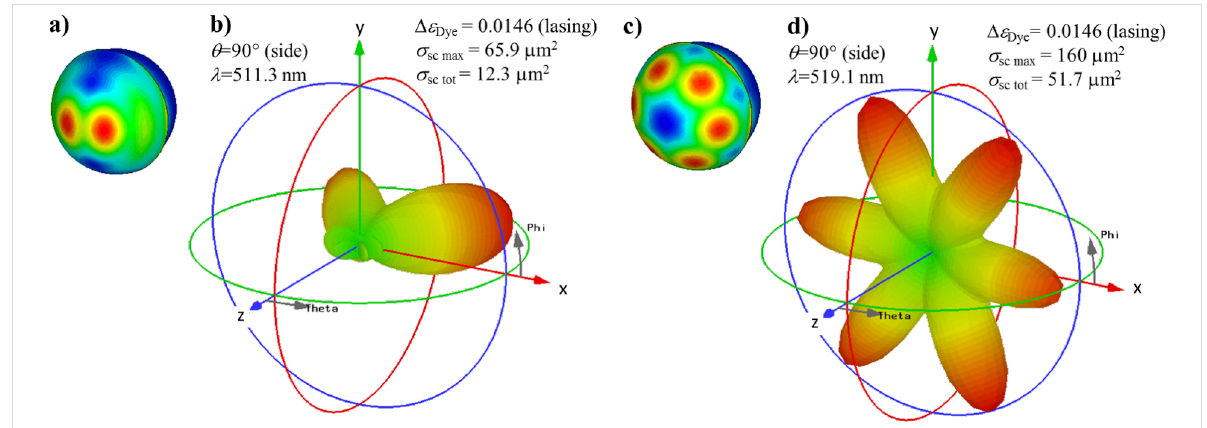
Figure 8: (a,c) Field enhancement | E |/ E 0 for two modes with gain close to the lasing threshold. The z-polarized incoming plane wave propagates in x-direction ( θ = 90°, φ = 0°). The two wavelengths 511.3 nm (a) and 519.1 nm (c) are close to the two peaks in Figure 6d. The semi-shell thickness h = 16 nm, and a gain strength Δε Dye = 0.0146 (near lasing condition) are assumed. (b,d) Differential scattering cross sections σ sc , linear scale. The maxima of differential and total σ sc are given in the legends.